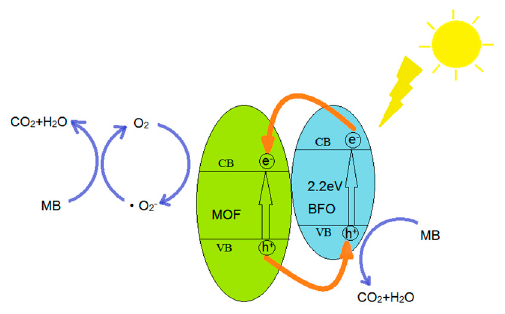
Figure 6. Schematic diagram for photocatalytic degradation of MB.